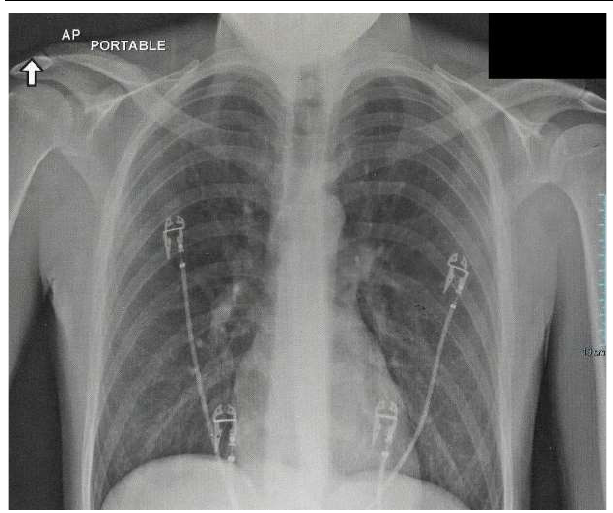
Figure 2 . Anterior-Posterior Chest X-Ray.